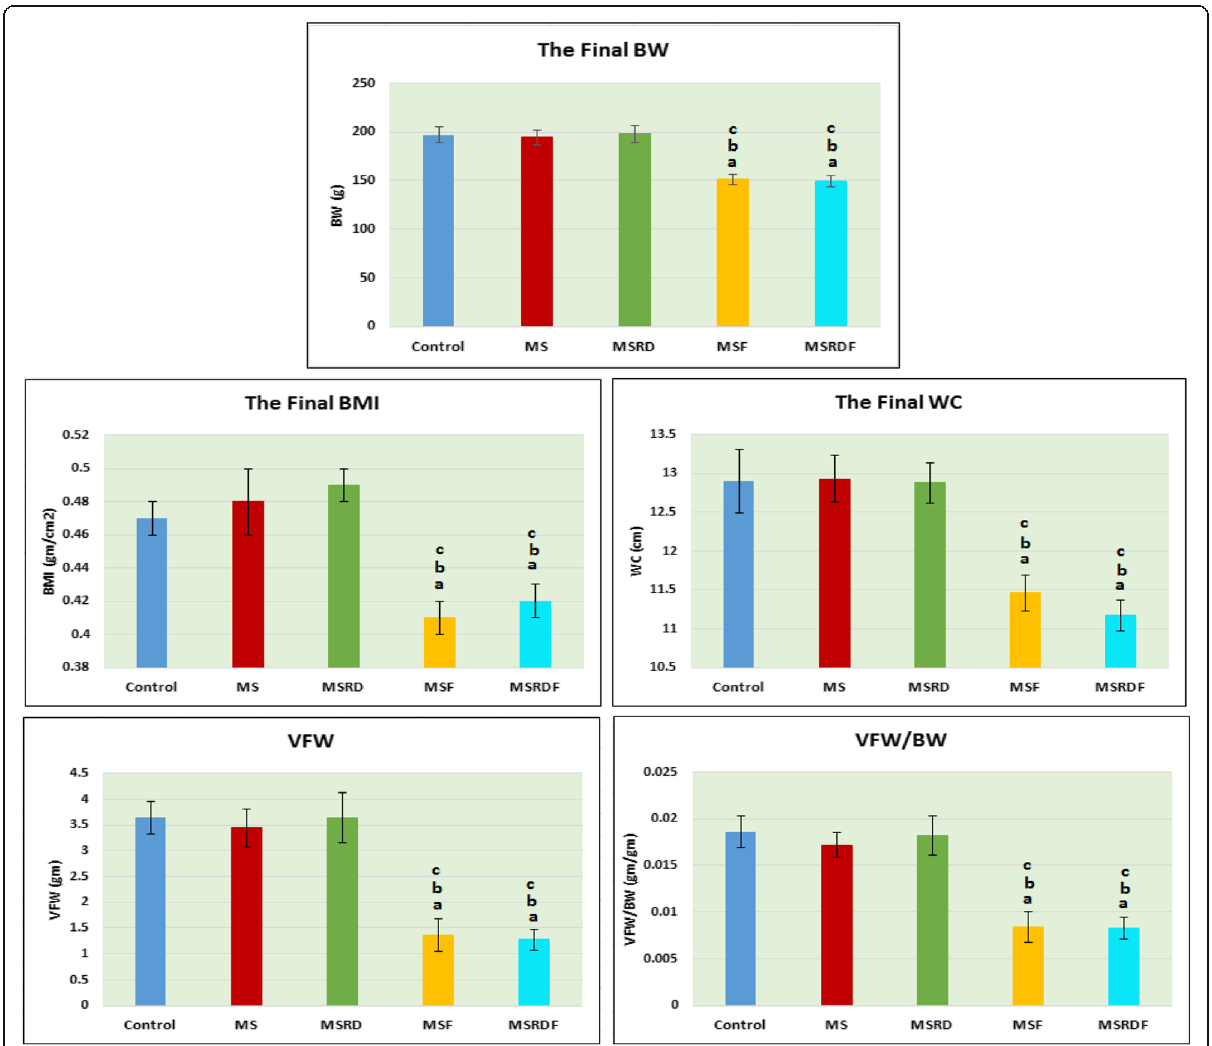
Fig. 4 The final anthropometric and visceral fat parameters in the five study groups. MS untreated metabolic syndrome group, MSRD